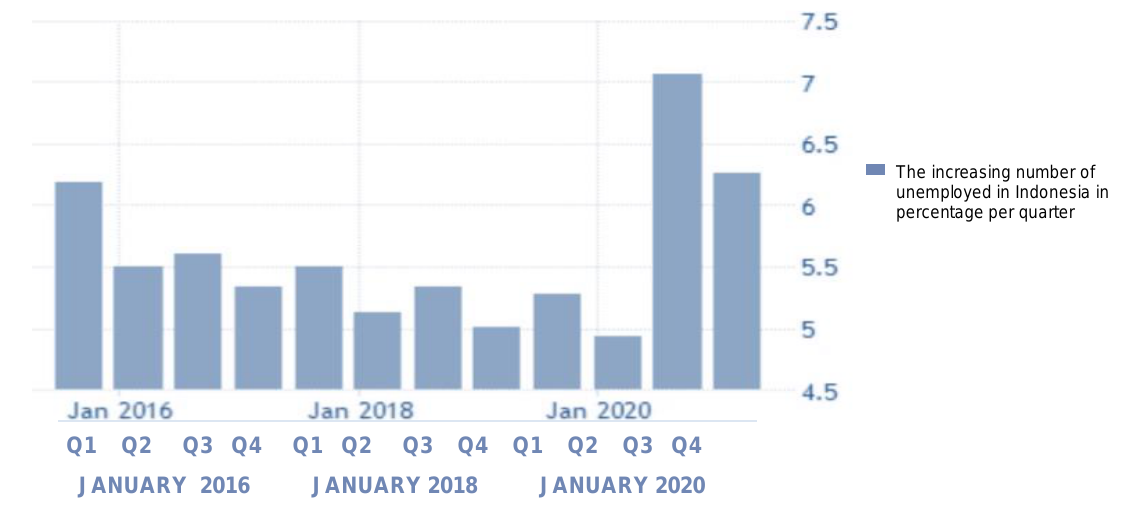
Figure 4: Unemployment in the midst of the economic downturn due to the Covid-19 pandemic crisis in Indonesia; Source: Trading Economics.Com/Statistic Indonesia (2021)